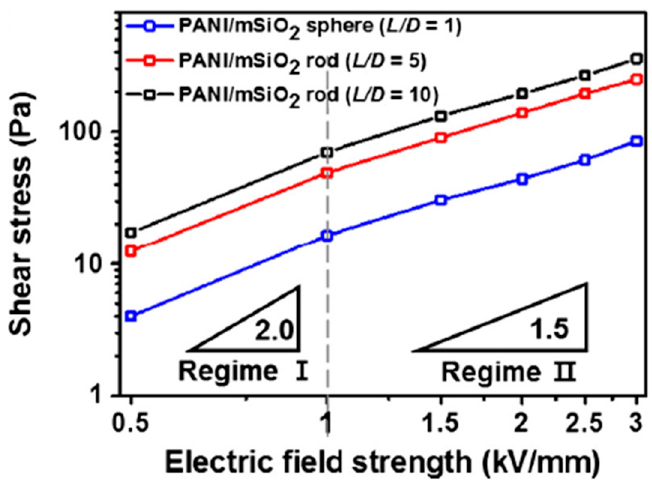
Figure 14. Yield stress of PANI/mSiO 2 -based ER suspension as a function of electrical field strength, reprinted with permission from [127]. Copyright Elsevier, 2016.